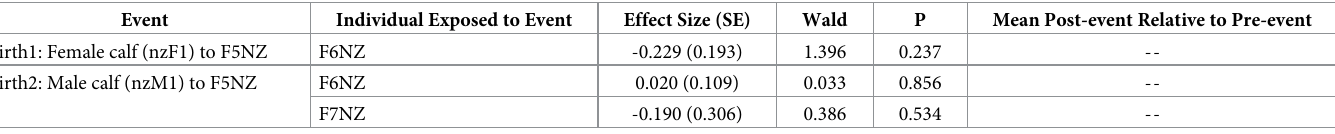
Table 4. Birth to a herdmate as a predictor of adrenal GC activity. Fixed effects, effect size with standard error (SE), Wald statistic, and p-value from GLMMs, and whether mean cortisol concentration post-event was higher or lower than pre-event. Degrees of freedom (df) was 1 in all pair-wise comparisons.